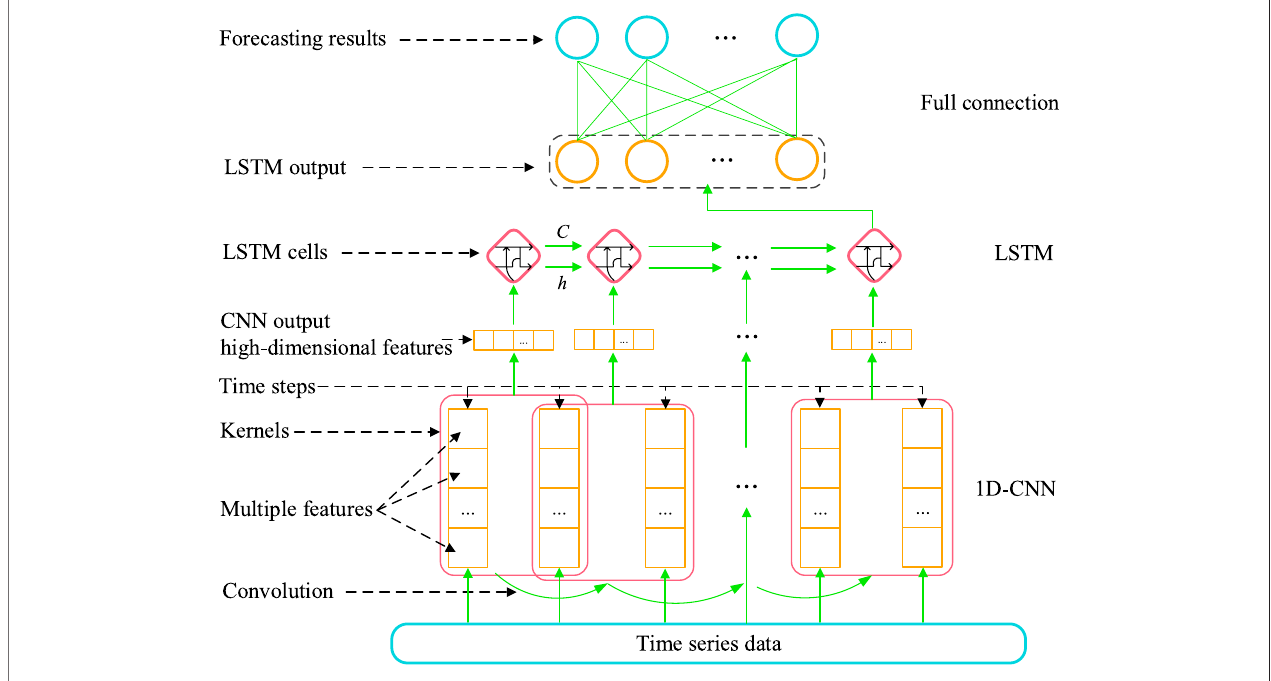
FIGURE 1 | Structure of the CLSTM prediction